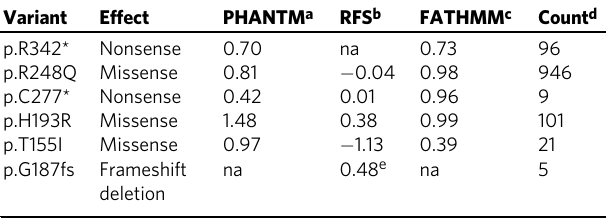
a The score is 0 for common benign polymorphisms and 1 for recurrent somatic hotspot mutations. b The score is on average − 2.50 for synonymous variants and 0.42 for protein truncating variants. c Scores above 0.5 are considered deleterious. d Number of somatic cases in the IARC TP53 database. e The exact nucleotidevariant was not characterised in RFS; the average score of LOF variants at codon 187 is